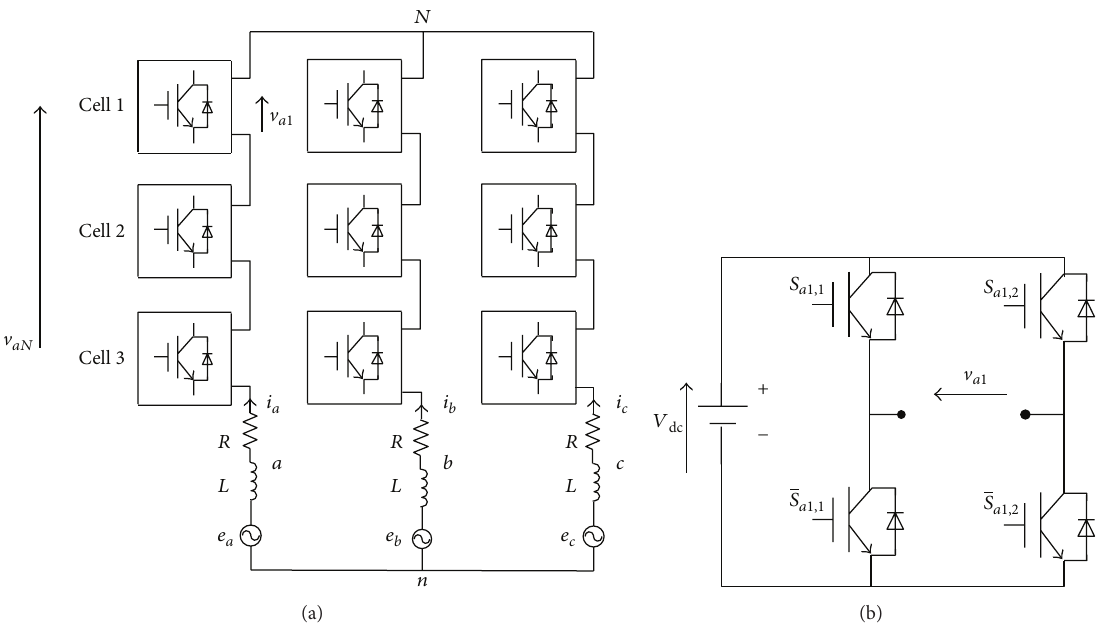
Figure 1: CHB inverter. (a) Three-cell CHB three-phase grid-connected inverter. (b) Topology of one